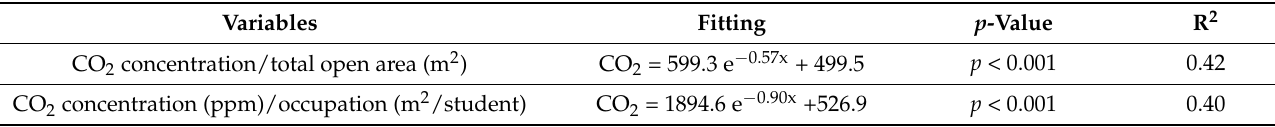
Table 7. Fitting